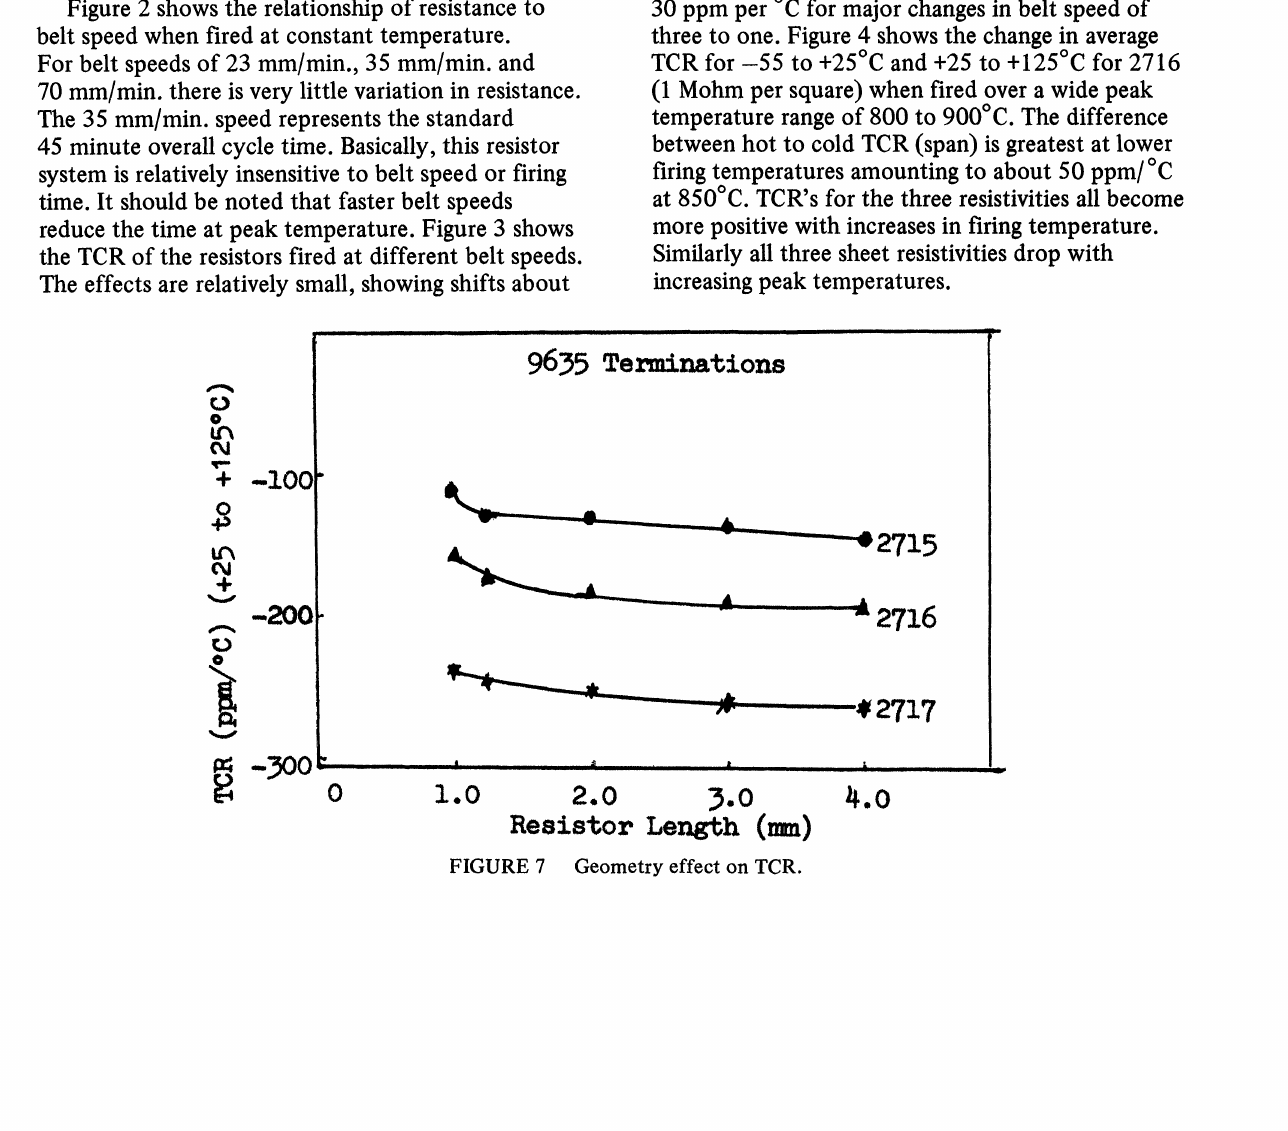
Iea+/-ator Length (ram) FIGURE 6 Geometry effect on resistance of 2716.